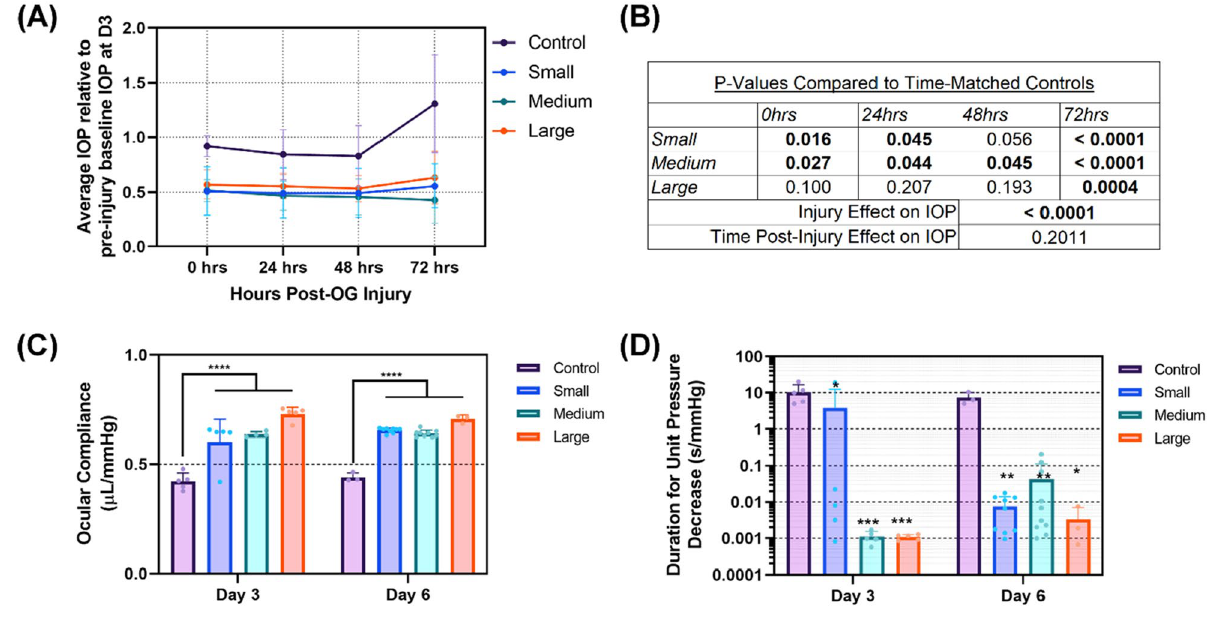
Figure 4. Mechanical property changes after OG injury in ASOC injury platform. ( A ) Average IOP relative to baseline levels immediately after injury and 24, 48, and 72 h post injury for control, small, medium, and large injury sizes. ( B ) Summary of statistical difference for IOP data for each injury state vs. its time matched control. p values for the injury and time effect on IOP are also shown, as determined by 2-way ANOVA. ( C ) Ocular compliance and ( D ) calculated durations per unit IOP from 18 to 15 mmHg for control, small, medium, large OG injury sizes immediately post injury (D3 organ culture) and 3 days post injury (D6 organ culture). Durations are logarithmically plotted to better show large and small values on a single plot. Results are shown as mean and error bars denote standard deviation throughout. Asterisks denote (*) p < 0.05, (**) p < 0.01, (***) p < 0.001, and (****) p < 0.0001 as determined by two-way ANOVA, post-hoc Dunnett’s